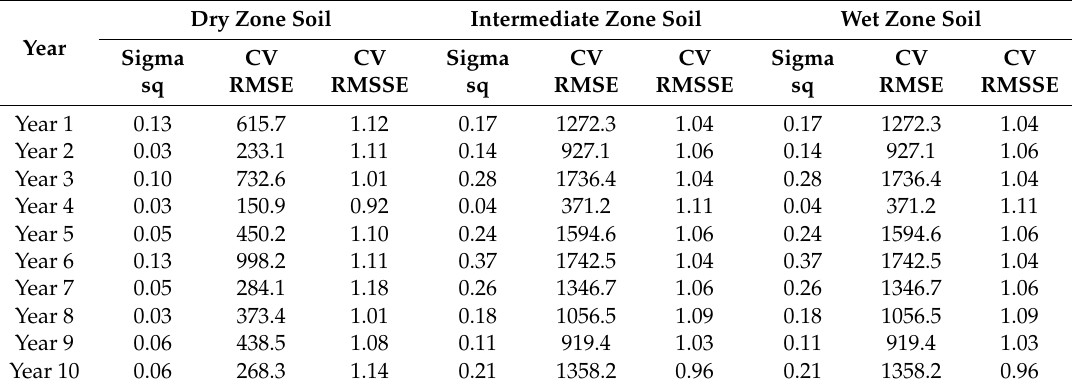
Table A1. The accuracy of the emulators developed to estimate the total above-ground dry matter (kg / ha) of rice (WAGT) for di ff erent environments in Sri Lanka.